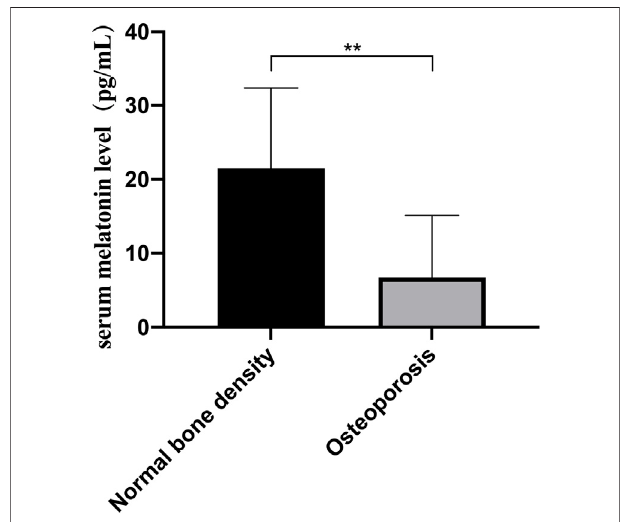
FIGURE 1 | Melatonin levels in women with osteoporosis decreased signi fi cantly. Blood samples were collected at 6:00 a.m. to determine the melatonin content in postmenopausal women with osteoporosis and young women with a normal bone mass using liquid chromatography-tandem mass spectrometry. Experiments were performed in triplicate, and data are shown asthe means ±standard deviations. * p < 0.05 or ** p < 0.01compared with young